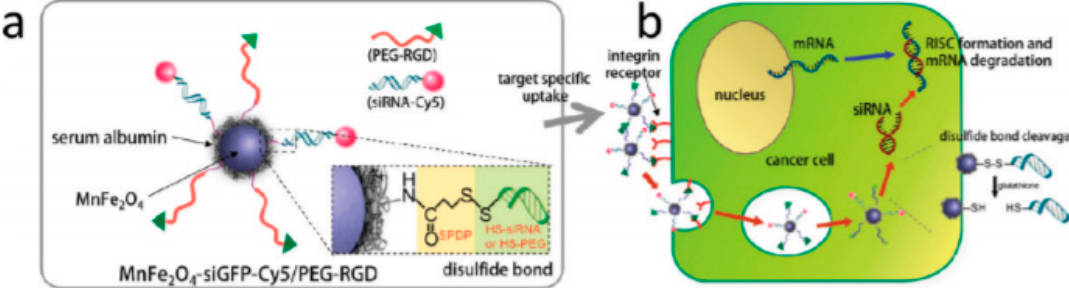
Figure 2. ( a ) All-in-one nanoparticles of MnFe2O4siGFPCy5 / PEG-RGD for theranostic purposes. Figure 2. All-in-one nanoparticles of MnFe2O4siGFPCy5/PEG-RGD for theranostic purposes. (b) ( b ) Schematic illustration of intracellular processes of MnFe2O4siGFPCy5 / PEGRGD nanoparticles, Schematic illustration of intracellular processes of MnFe2O4siGFPCy5/PEGRGD nanoparticles, from from target-specific uptake to mRNA degradation. Reprinted with permission from target-specific uptake to mRNA degradation. Reprinted with permission from [103].